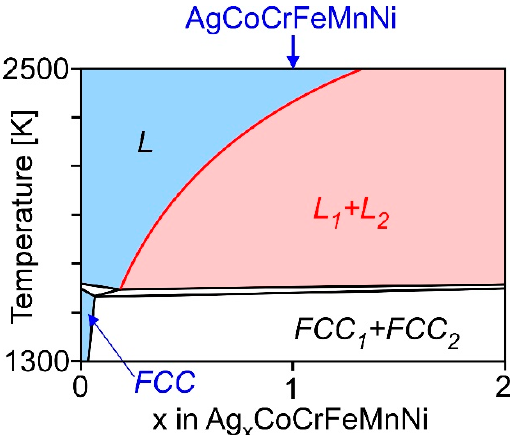
Figure 13. Calculated phase diagram of the pseudo-binary CoCrFeMnNi-Ag 2 CoCrFeMnNi focusing on LPS. The liquid miscibility gap is shown using the red line.